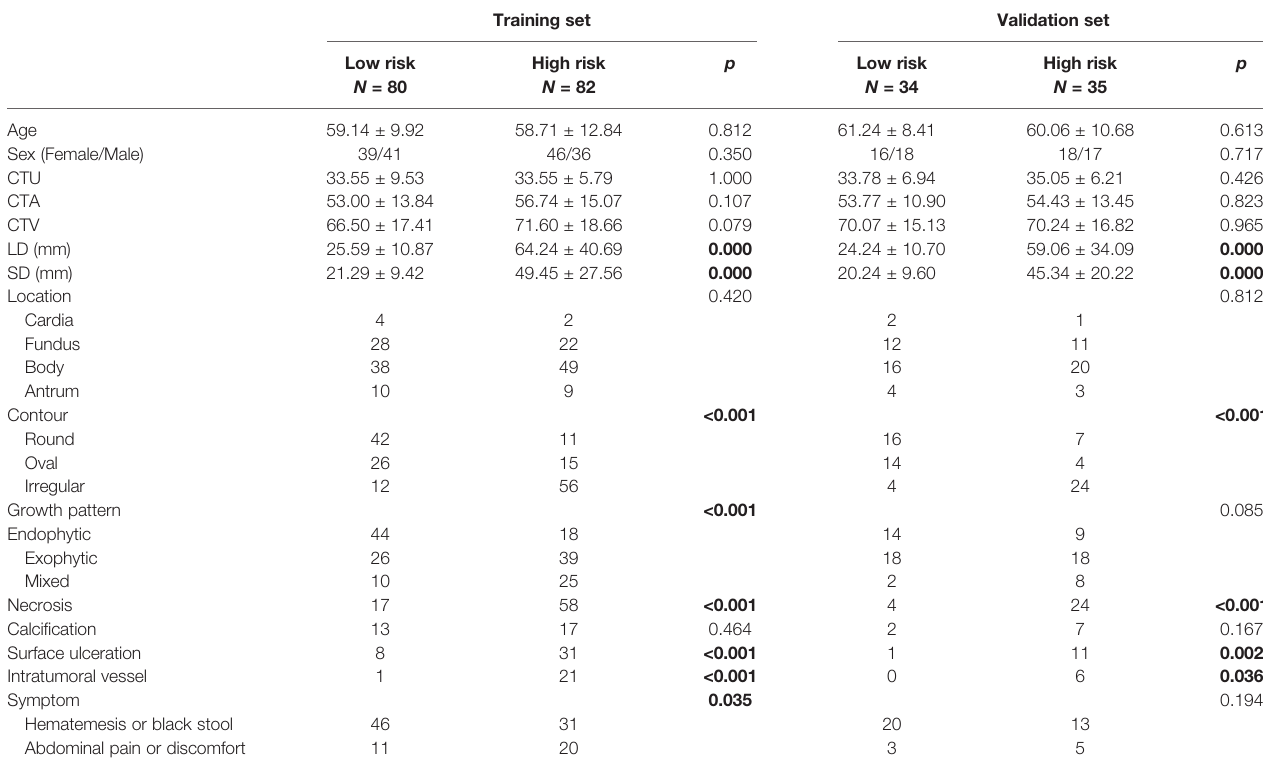
TABLE 1 | The clinical characteristics and CT features in the training and validation sets.